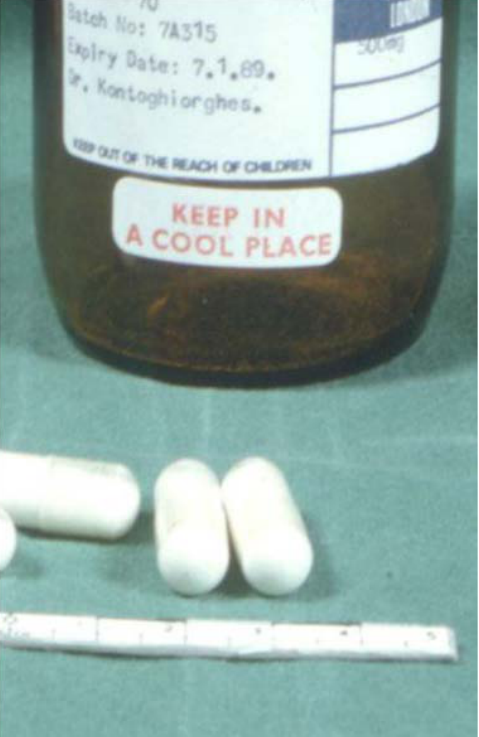
Figure 2. The first pharmaceutical formulation of deferiprone (L1) in transparent gelatin capsules, which were used for the first clinical trials in London, UK, and also in multicenter clinical trials that followed worldwide. Each capsule contained 0.5 g of L1 white solid, with no preservatives or additives (see https://www.youtube.com/watch?v=ZcvSLyIgYd8 , accessed on 3 March 2023).